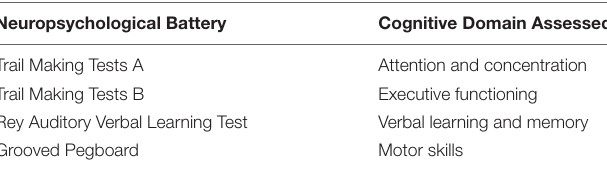
TABLE 1 | Neuropsychological battery recommended by the 1995 “Statement of Consensus” for the assessment of POCD following cardiac surgery